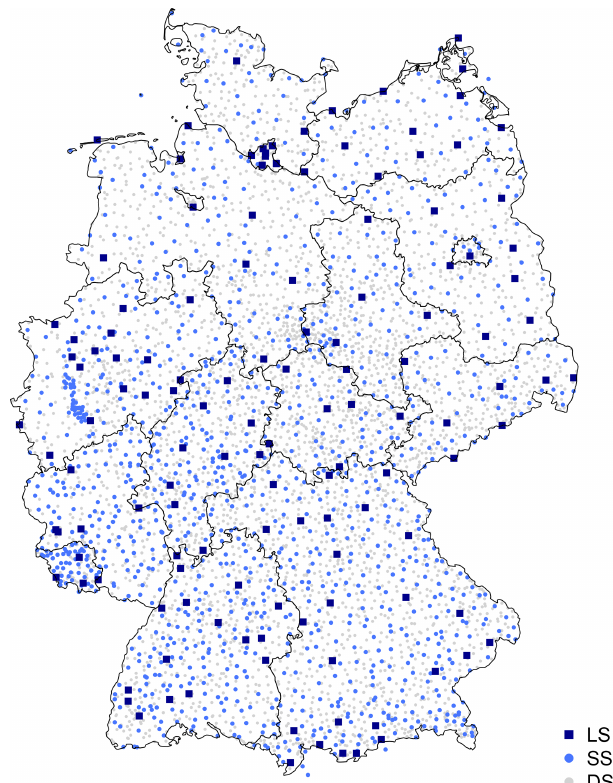
Figure 1. Available rainfall data types in Germany categorised in three groups: long series (LS), short series (SS) and daily series (DS). The black lines illustrate the borders of German federal states.